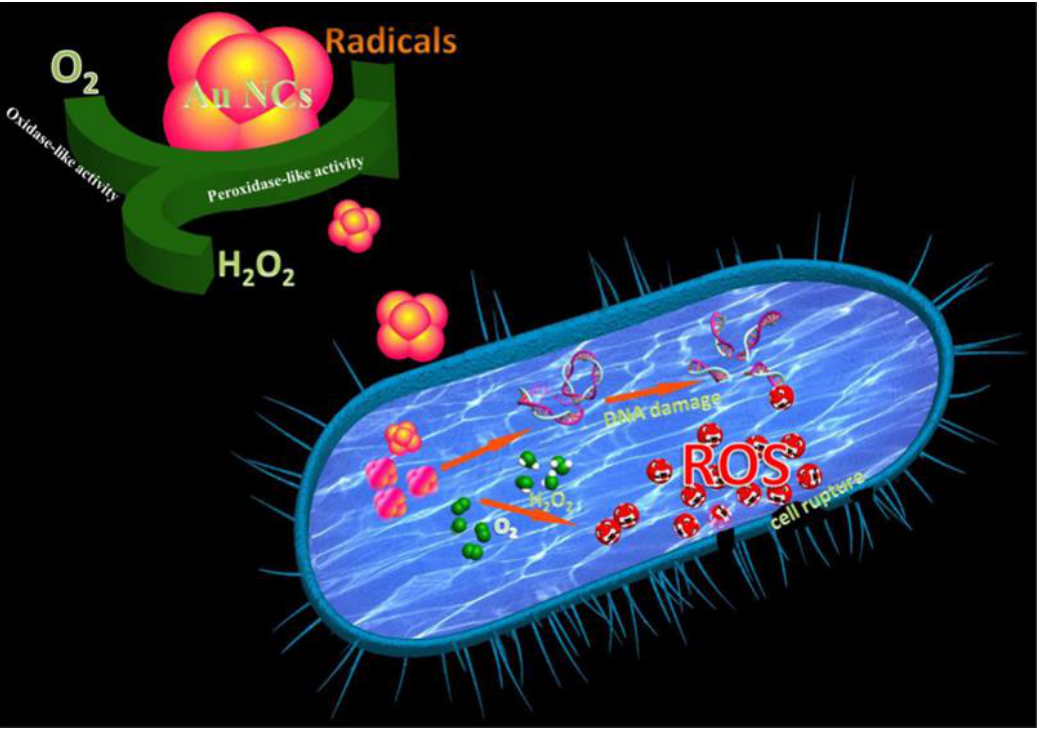
Figure 5. The mechanisms of cell membrane destruction, DNA damage and ROS generation for AuDAMP to kill bacteria. Reproduced with permission from Reference [76]. Copyright © 2018, American Chemical Society.